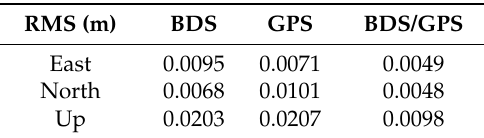
Table 1. Expected RMS of BDS, GPS, and joint BDS/GPS real-time precise positioning using TPP in South-East